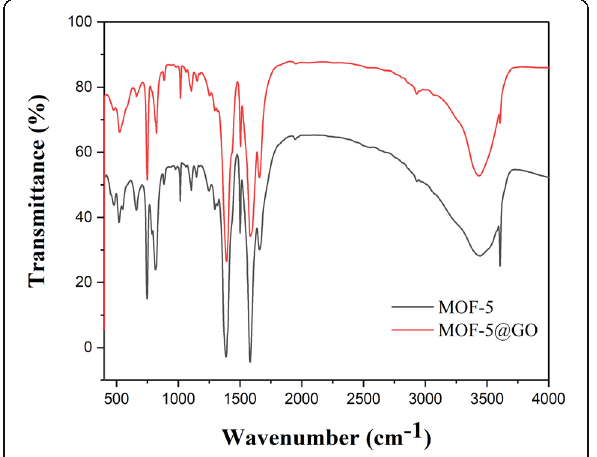
Fig. 5. FT-IR spectra of MOF-5 and